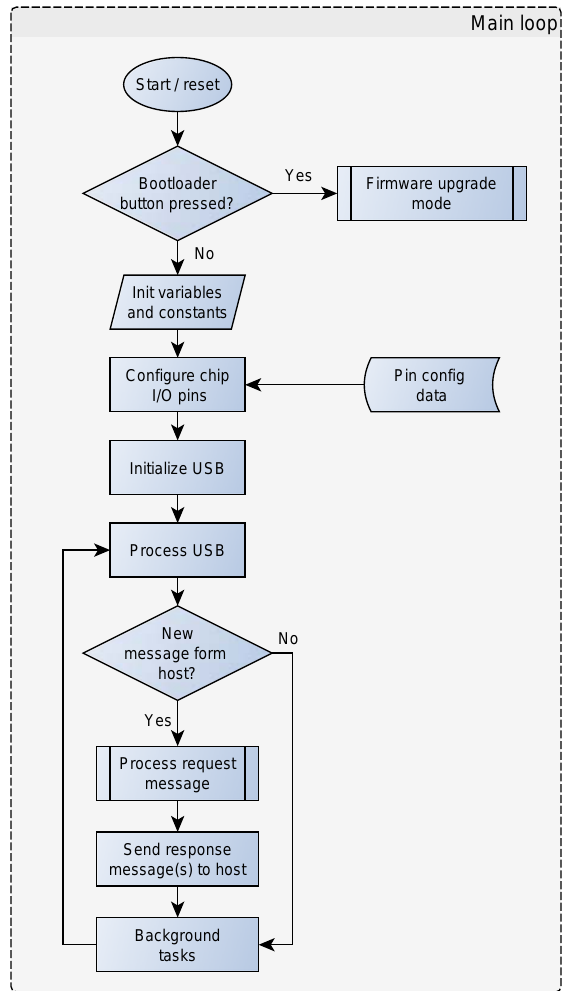
Figure 3 . SimpleDAQ firmware flowchart: Main